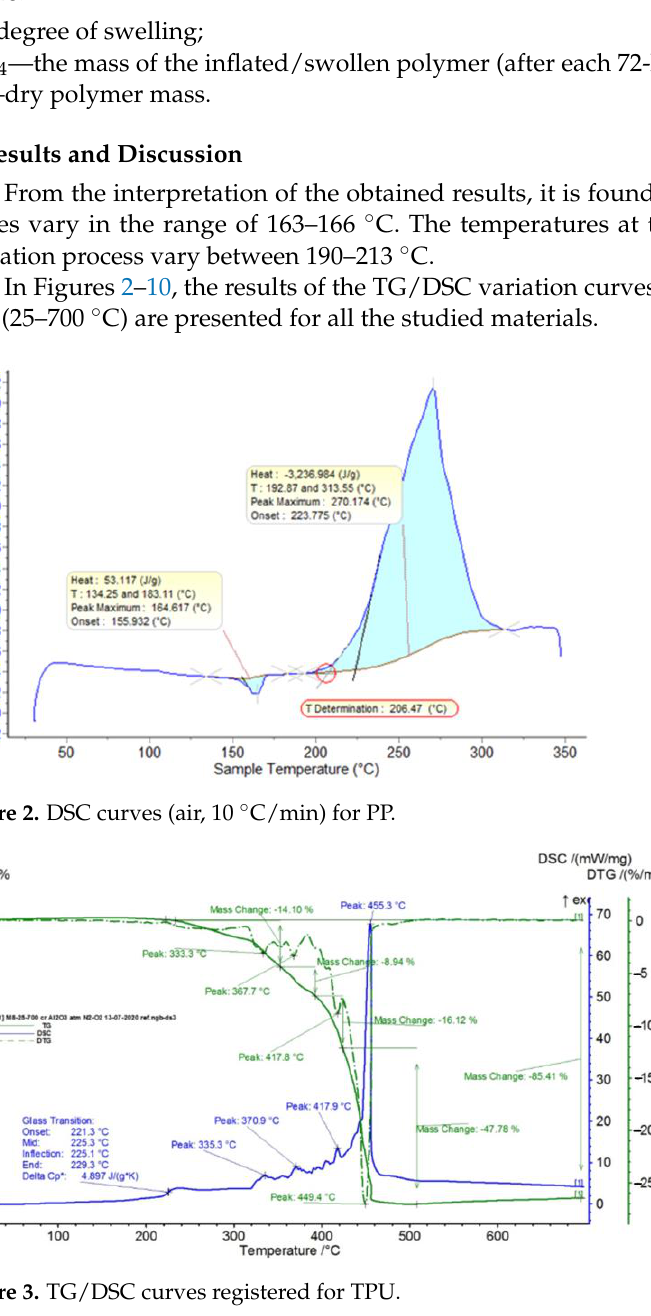
Figure 4. TG/DSC curves registered for BaTiO 3. Figure 5. TG/DSC variation for sample M1.